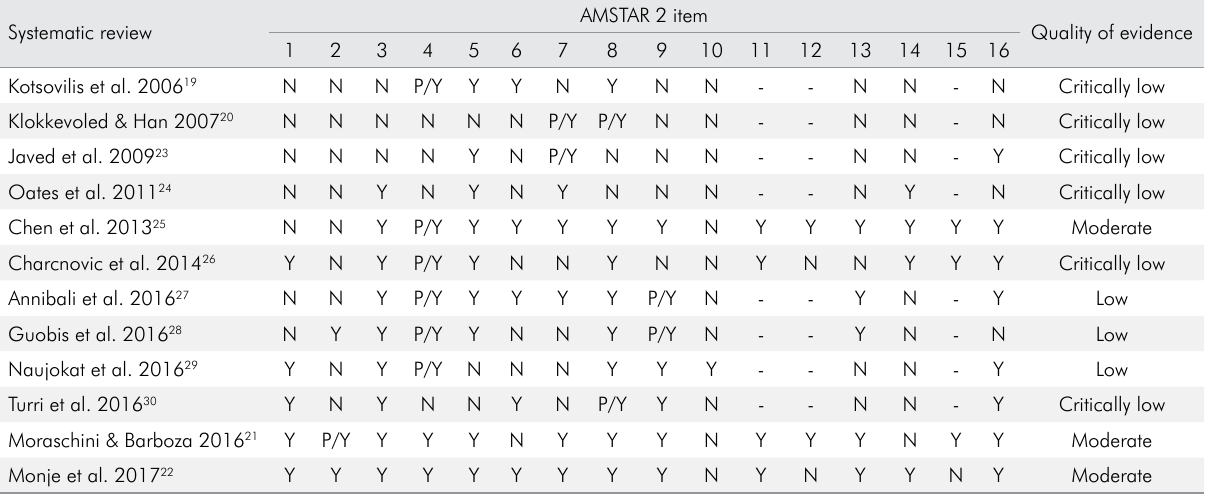
Table 4. Assessment of the methodological quality of the systematic reviews included, using the AMSTAR 2 instrument. Systematic